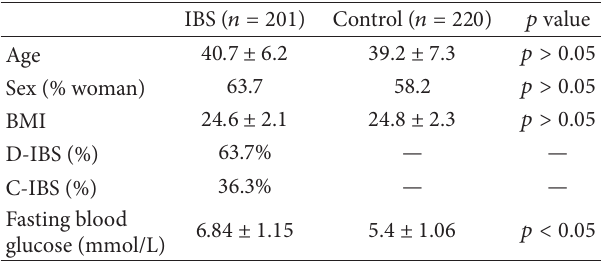
Table 1: Characteristics of IBS and healthy